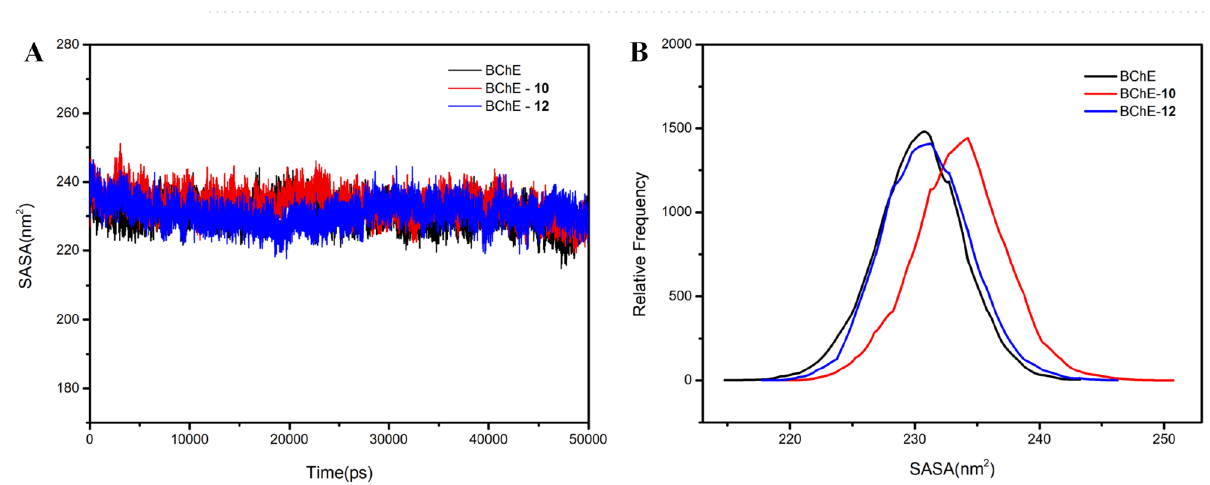
Figure 6. The SASA ( A ) and relative frequency ( B ) of 10 and 12 with